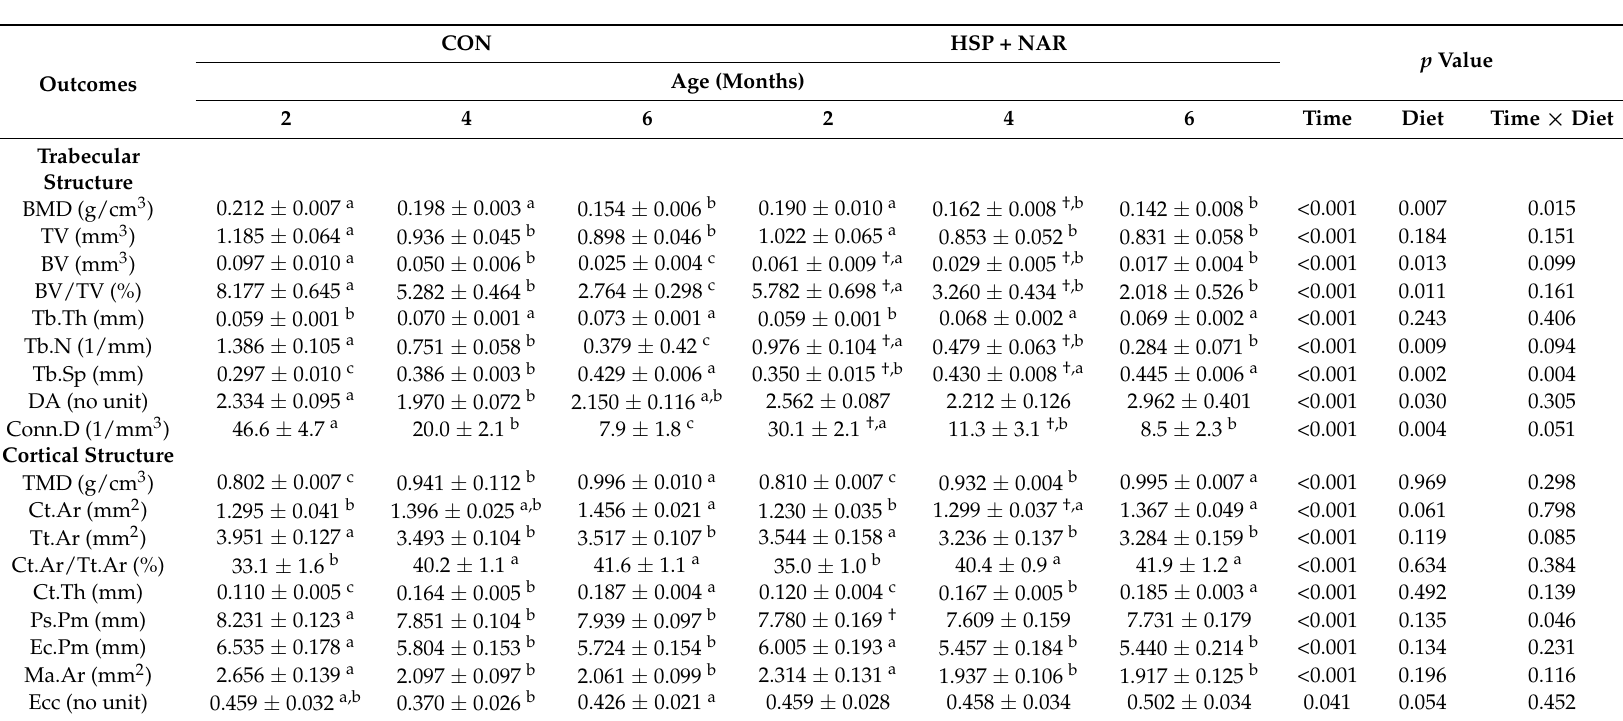
Table 1. Bone mineral density (BMD) and structure at the proximal tibia at 2, 4, and 6 months of age in female CD-1 mice whose mothers were exposed to control (CON) or 0.5% hesperidin (HSP) and 0.25% naringin (NAR) diets through pregnancy and lactation.